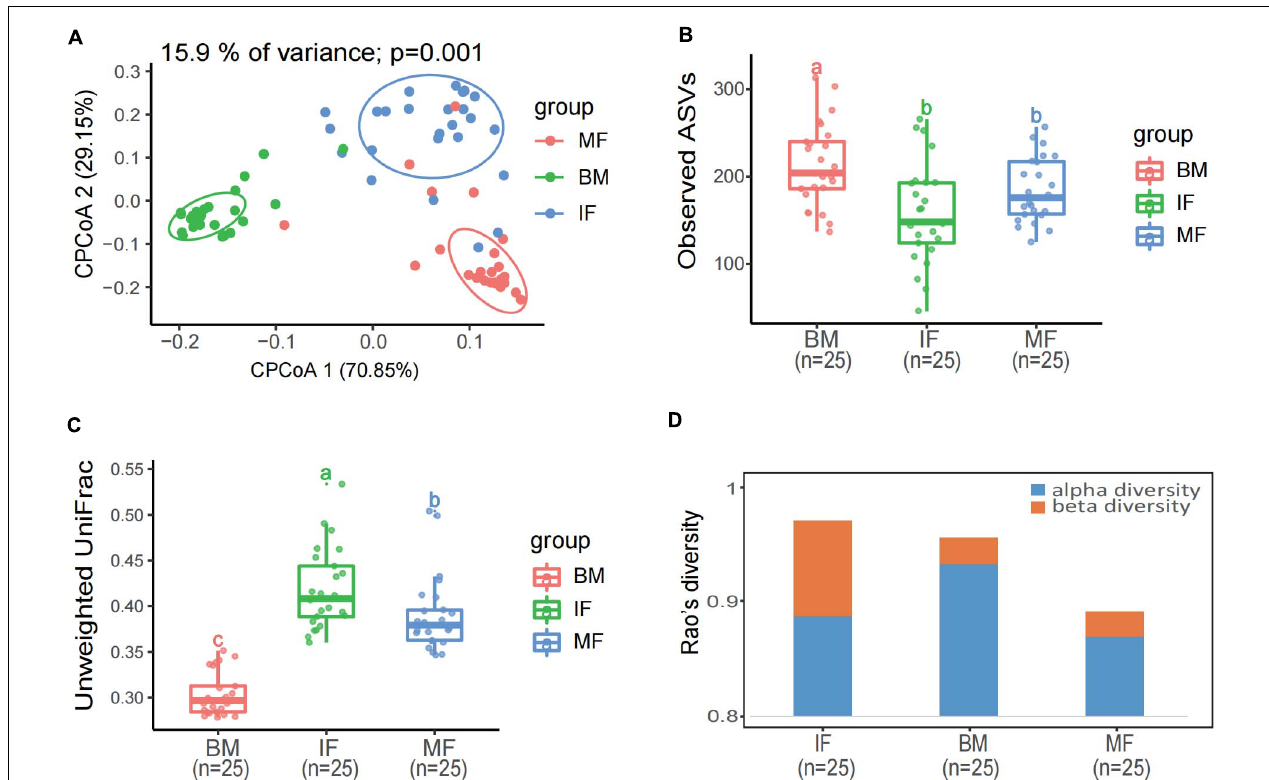
FIGURE 3 | Diversity analysis of bacterial communities in infant feces, maternal feces, and breast milk samples. (A) Constrained principal coordinate analysis plot of Bray–Curtis distances between samples including three groups (15.9% of variance, p = 0.001; n = 75). Ellipses represent a 95% confidence interval around the cluster centroid. IF, infant feces; MF, maternal feces; BM, breast milk. (B) Box plot of the observed ASV index and (C) intragroup unweighted UniFrac distances calculated for maternal feces group (red), breast milk group (green), and infant’s feces group (blue) samples. Statistical analysis was performed using the permutational multivariate analysis of variance. (D) The α -diversity and β -diversity of three groups determined by Rao’s diversity decomposition at the ASVs level, considering both phylogeny and relative abundance.